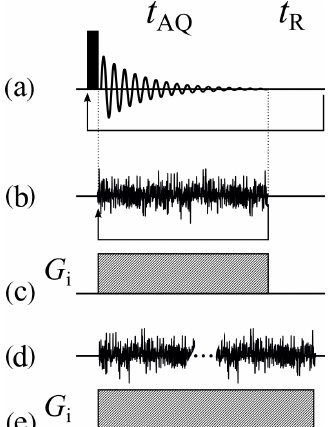
Figure 3. Basic acquisition sequences. (a) Acquisition sequence of the simplest 1D pulsed experiment. (b) The corresponding spin- noise-detected NMR acquisition sequence. The arrows in panels (a) and (b) represent the loops for recording all the scans. (c) The frequency-encoding gradient for panels (a) and (b) if used as an imaging experiment. (d) Same as panel (b) , but all data blocks are recorded continuously in one long acquisition period. (e) The frequency-encoding gradient for panel (d) if used as an imaging ex- periment. t AQ and t R denote the acquisition time and recycle delay,